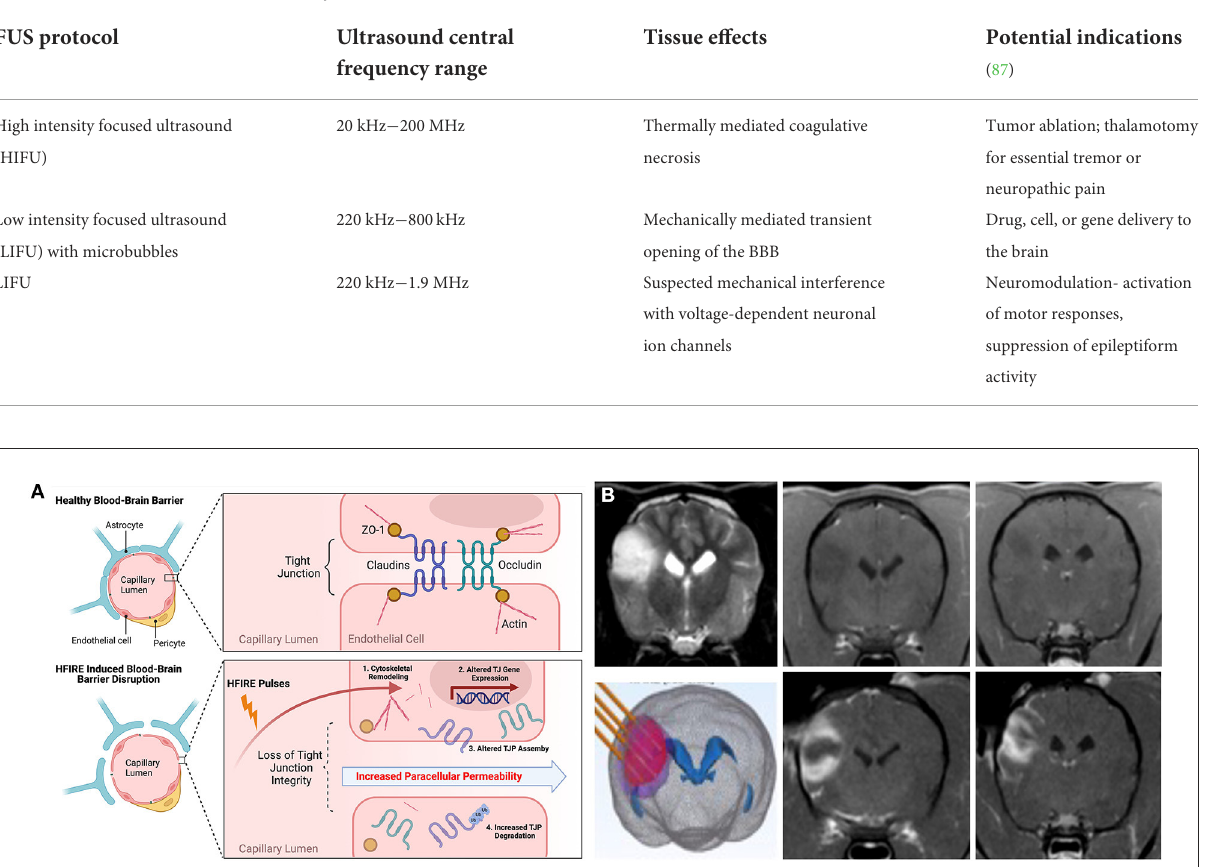
TABLE 1 Focused ultrasound treatment protocols and indications in the brain.